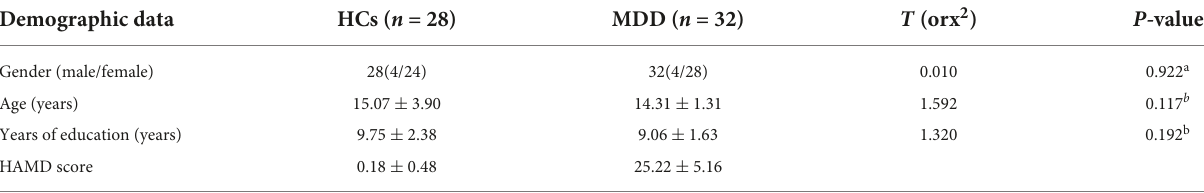
TABLE 1 Demographic characteristics of healthy controls (HCs) and major depressive disorder (MDD) patients. Demographic data